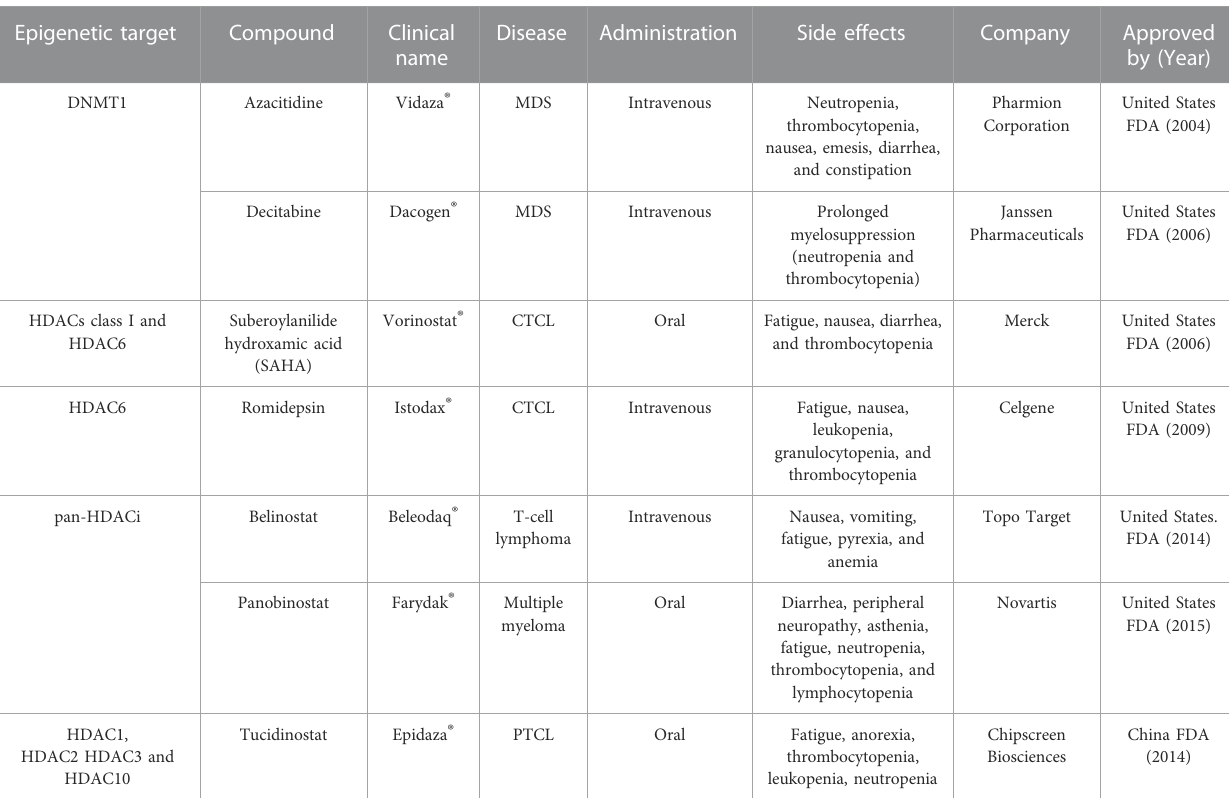
TABLE 1 Epigenetic drugs approved by